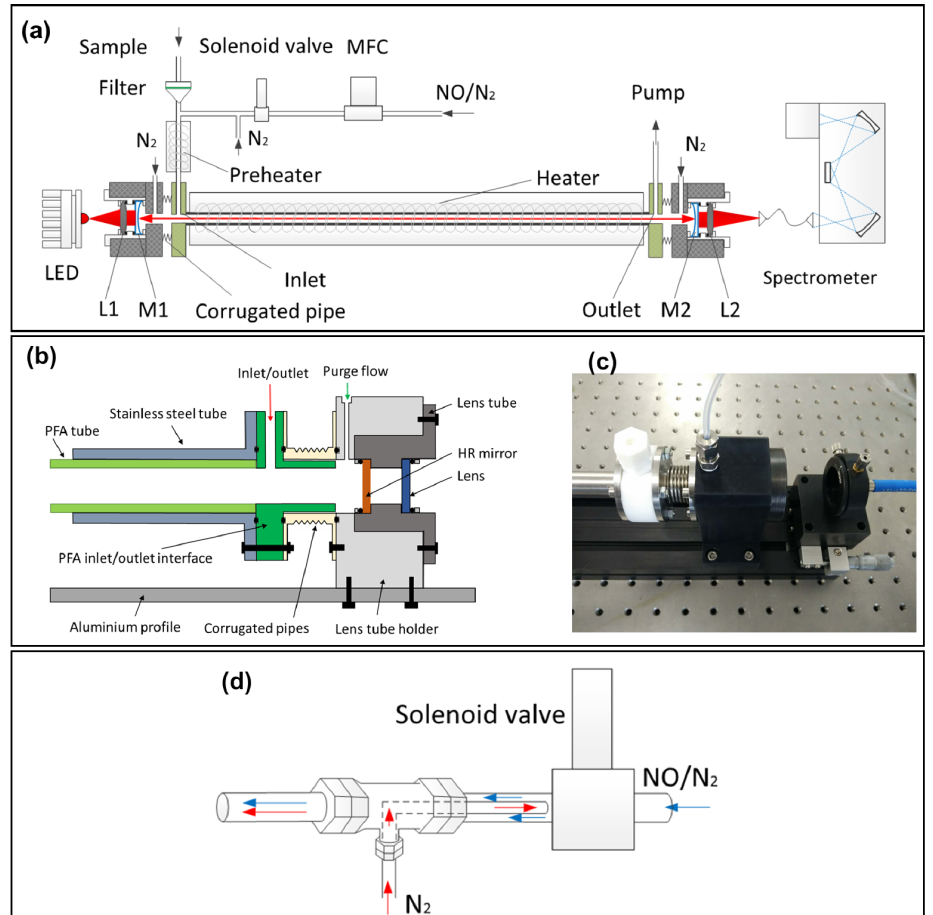
Figure 1. A schematic of the newly developed IBBCEAS instrument for the detection of NO 3 and N 2 O 5 . (a) Overview of the optical layout (LEDs, collimating optics, high-finesse cavity, and spectrometer) and the flow system (aerosol filter, inlet, NO titration module, preheating tube, and detection cell). (b) The schematic layout of the mirror mounts, which enables a mechanical alignment of the high-reflectivity (HR) mirrors. (c) A photograph of the mirror mounts. (d) The schematic layout of the NO titration module; the red arrow denotes the N 2 gas flow, and the blue arrow denotes the NO gas